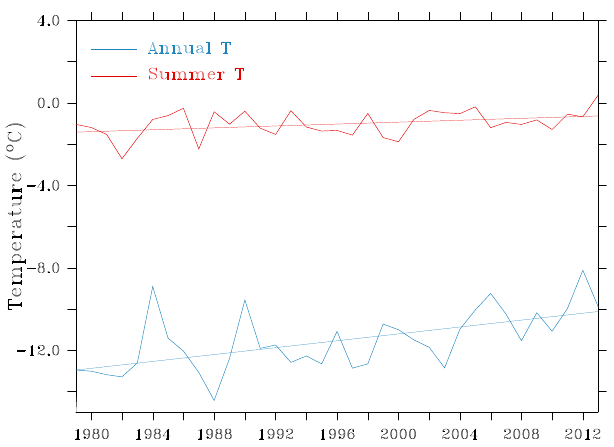
Figure 6. Evolution of the mean annual (blue) and summer (red) MAR ERA TAS ( ◦ C) integrated over the permanent ice area between 1979 and 2013 with their linear